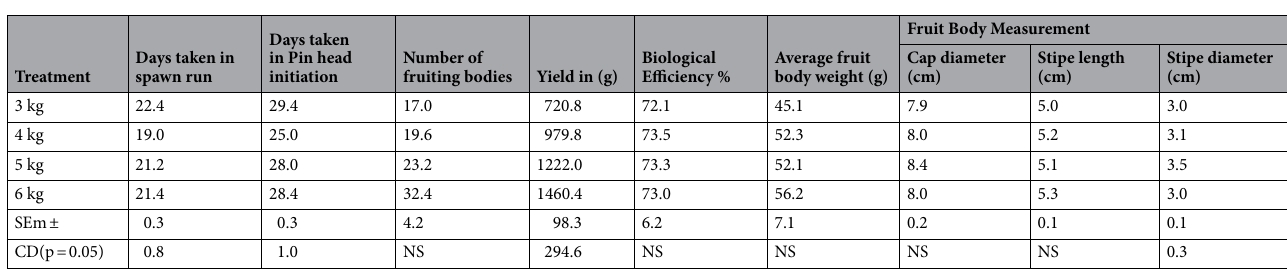
Table 4. Effect of different substrate quantities on spawn run, pinhead initiation, yield and morphology of Pleurotus eryngii. SEm ± : Standard error of the mean. CD(p = 0.05) : Critical difference. All the observations are average of five